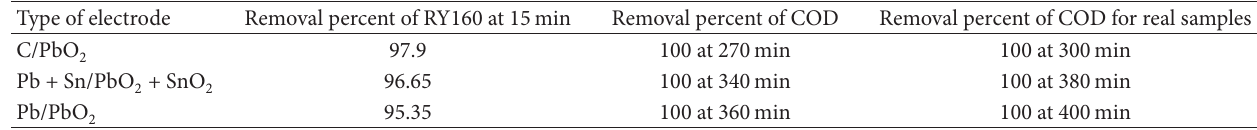
T 1: Percentage of COD and concentration removal of RY160 on C/PbO conditions.